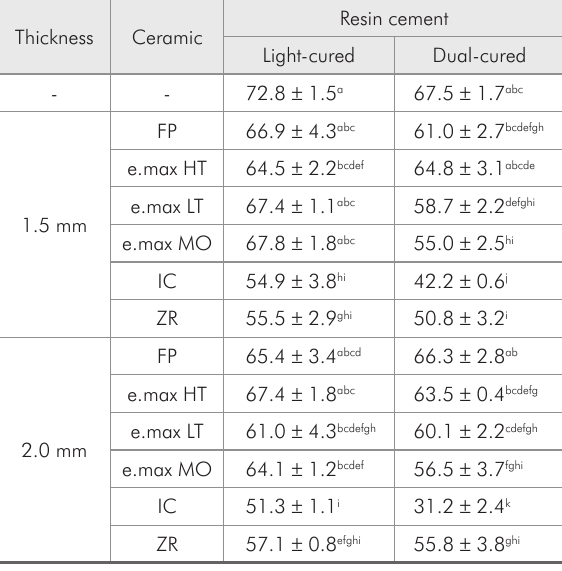
Table 1 - Means and standard deviations for the degree of conversion (in